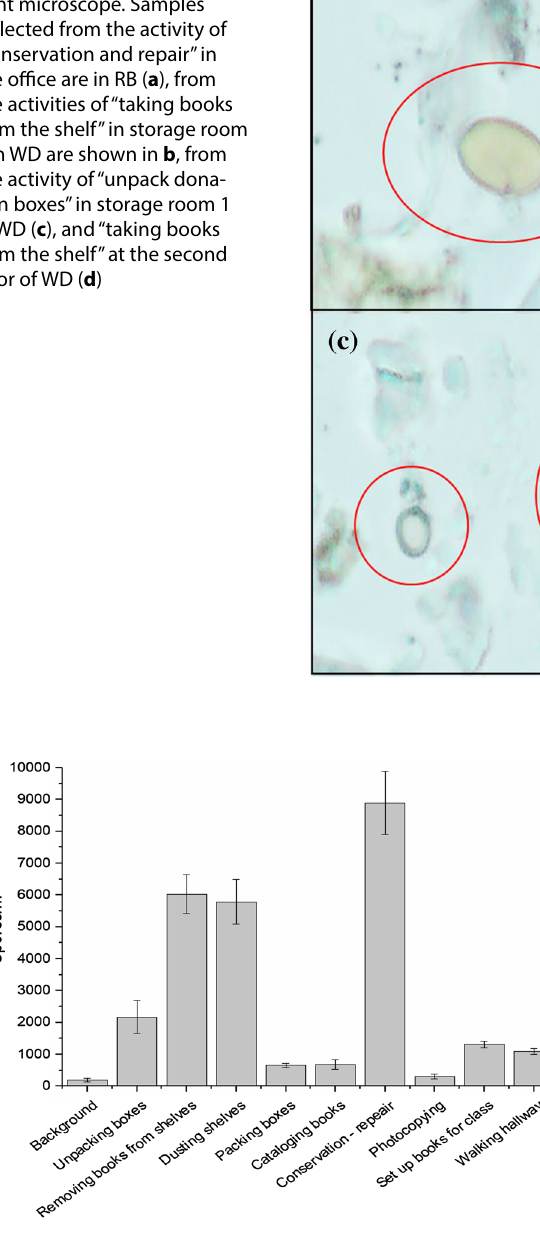
Fig. 4 Examples of mold spores recognized under a light microscope. Samples collected from the activity of “conservation and repair” in the office are in RB ( a ), from the activities of “taking books from the shelf” in storage room 2 in WD are shown in b , from the activity of “unpack dona- tion boxes” in storage room 1 in WD ( c ), and “taking books from the shelf” at the second floor of WD ( d )